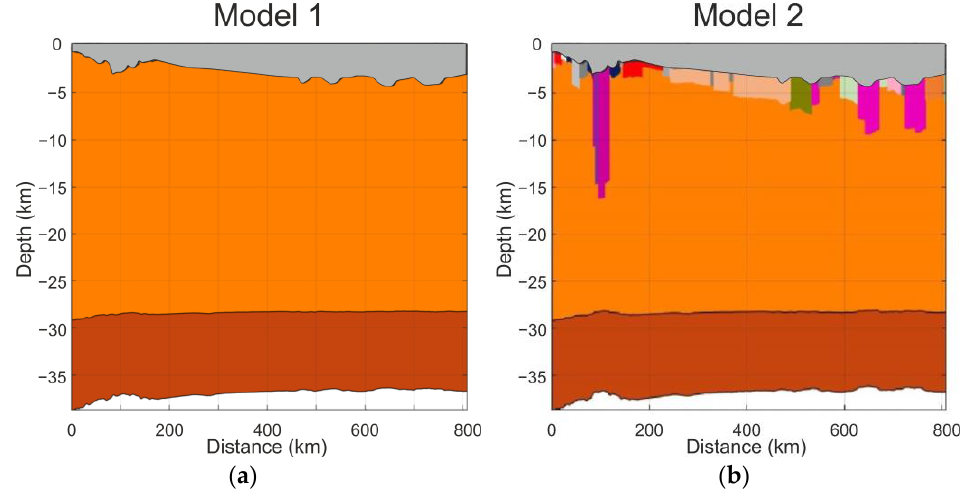
Figure 6. Reconstructed present-day geological sections for ( a ) Model 1 and ( b ) Model 2. The grey area is the basin part. The colour codes beneath the basin part correspond to the basement units presented in Table 1. The corresponding modelled gravity anomalies are presented in Figure 4. The layer of the lithospheric mantle is not displayed for the convenience of presenting the picture.